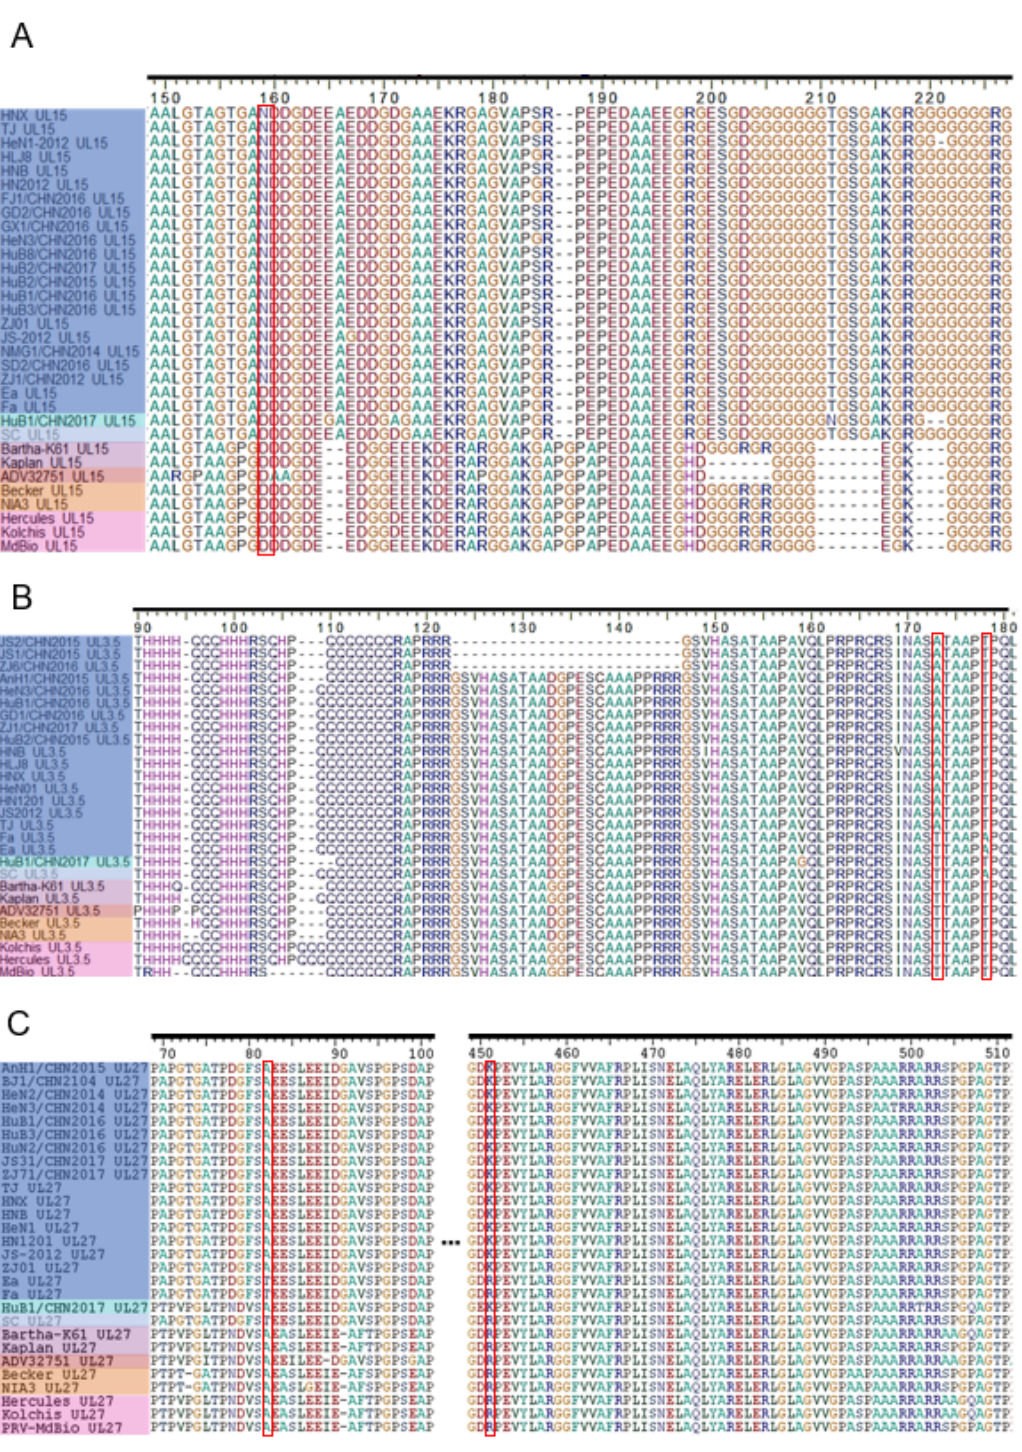
Figure 4. Presentative amino acid (AA) variation in UL15, UL3.5, and UL27. Partial regions of the amino acid (AA) alignment of UL15 ( A ), UL3.5 ( B ), and UL27 ( C ) are displayed in the three panels. To make the alignment easy to display, the redundancy of newly sequenced ORFs is reduced, while all the reference sequences are maintained. The panel of the strain name is covered by colored boxes, which represent their genetic clades with the same color scheme used in Figure 3A. The distinguishing mutations that distinguish PRV strains from classic strains are highlighted by red boxes.